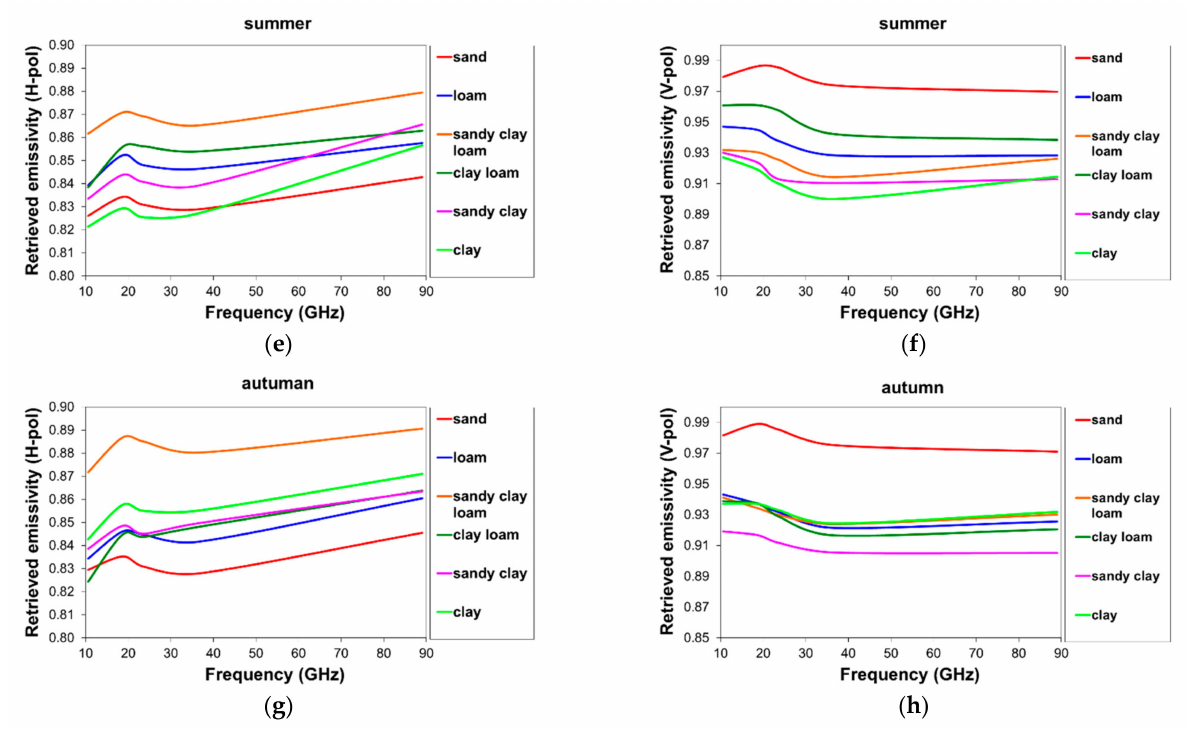
Figure 2. MWRI retrievals of mean land surface emissivity vs. soil types in ( a , b ) winter, ( c , d ) spring, ( e , f ) summer, and ( g , h ) autumn: ( a , c , e , g ) Horizontal-polarization (H-pol); ( b , d , f , h ) Vertical- polarization (V-pol).